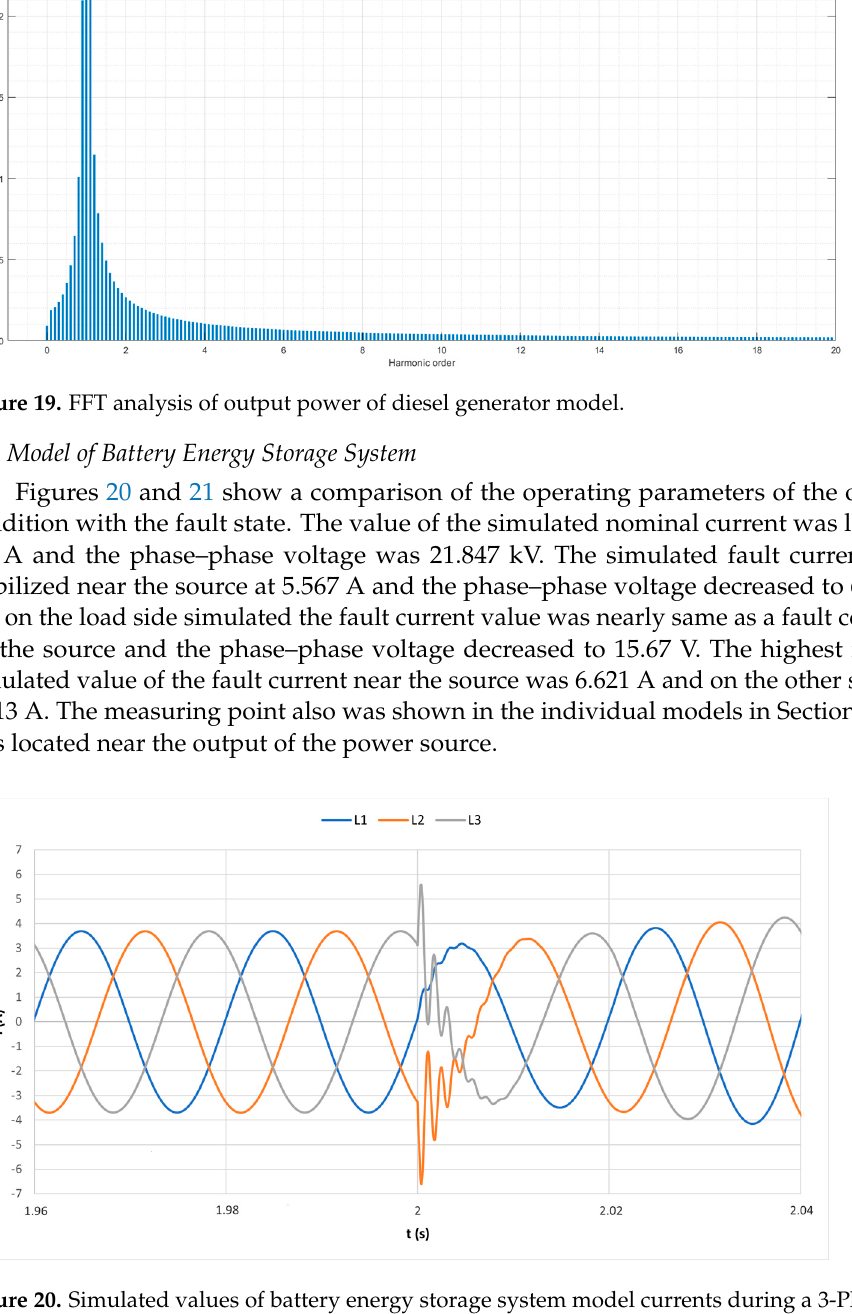
Figure 18. Simulated values of diesel generator model voltages during a 3-Ph ground fault condition at: ( a ) the source; ( b ) the end of transmission line.